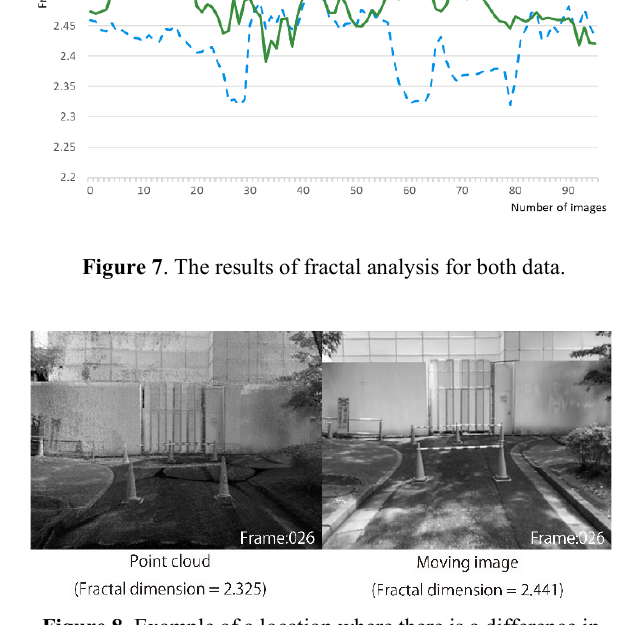
Figure 8 . Example of a location where there is a difference in fractal dimension between the video image and the point